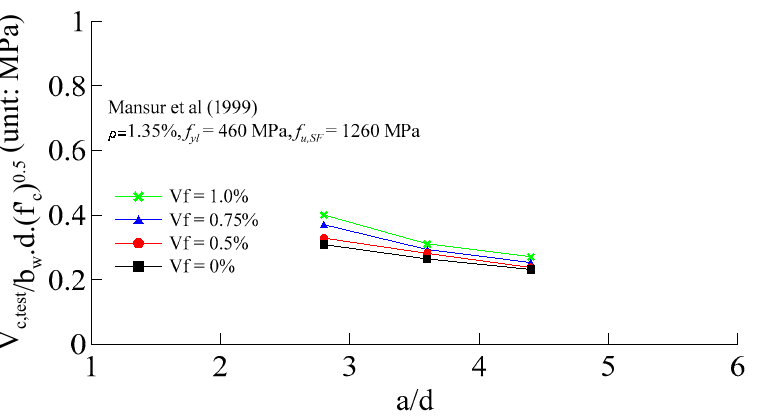
Figure 1. The relationship between normalized shear stress and shear span-to-effective depth ratio [11].